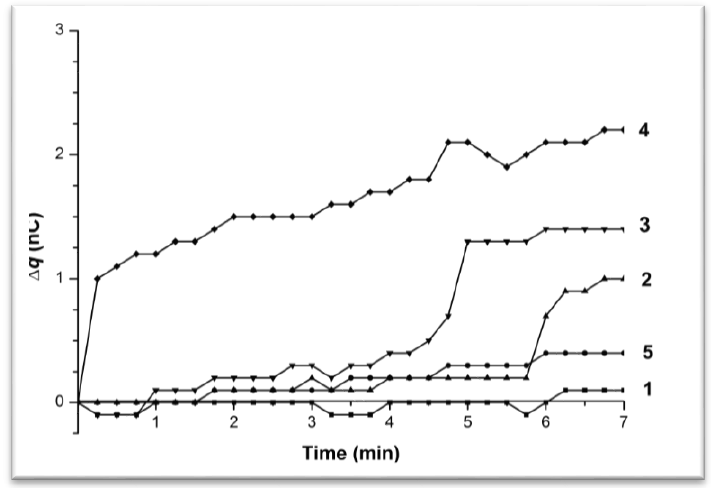
Figure 2. Time dependence curves of charge accumulation ∆q(t) upon water influx from the tip in the flow-through system at 35 °C. Curves 1–5 represent parallel measurements of one and the same experimental